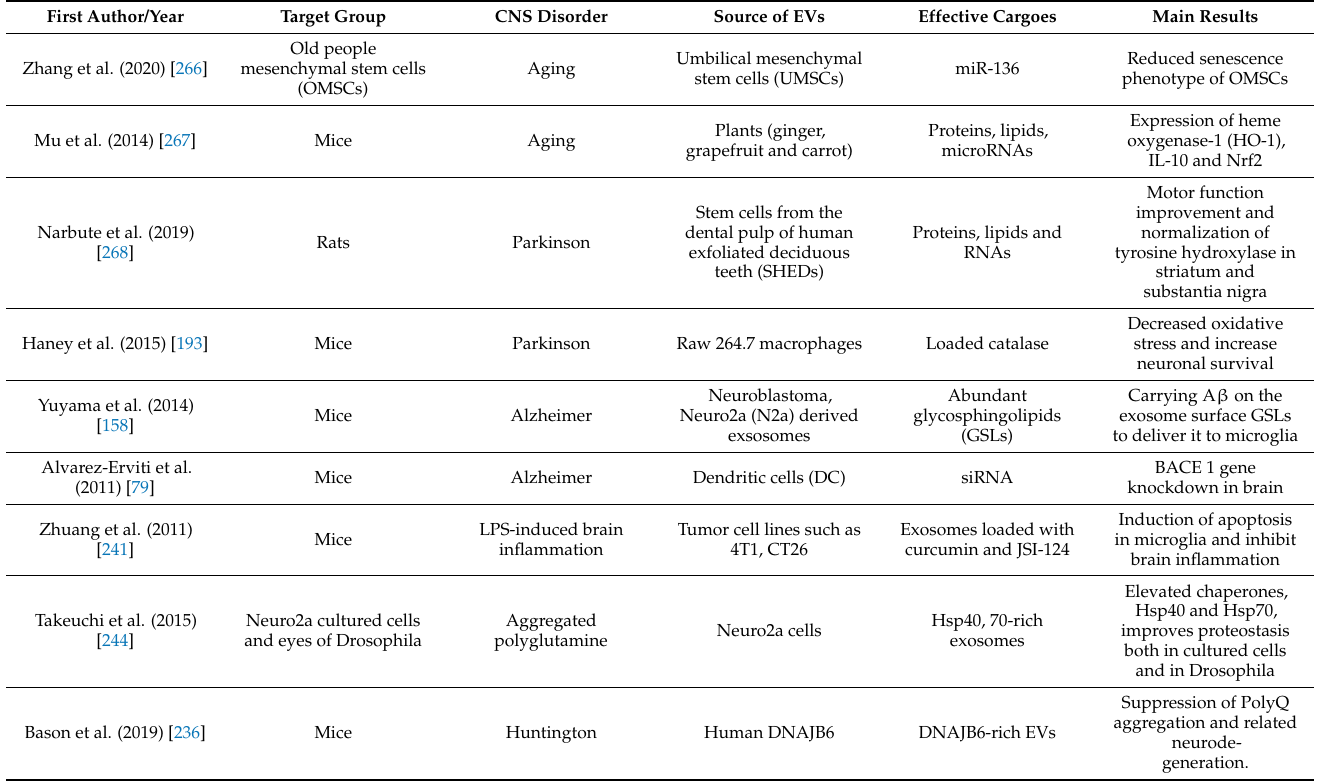
Table 3. Therapeutic applications of EVs in CNS